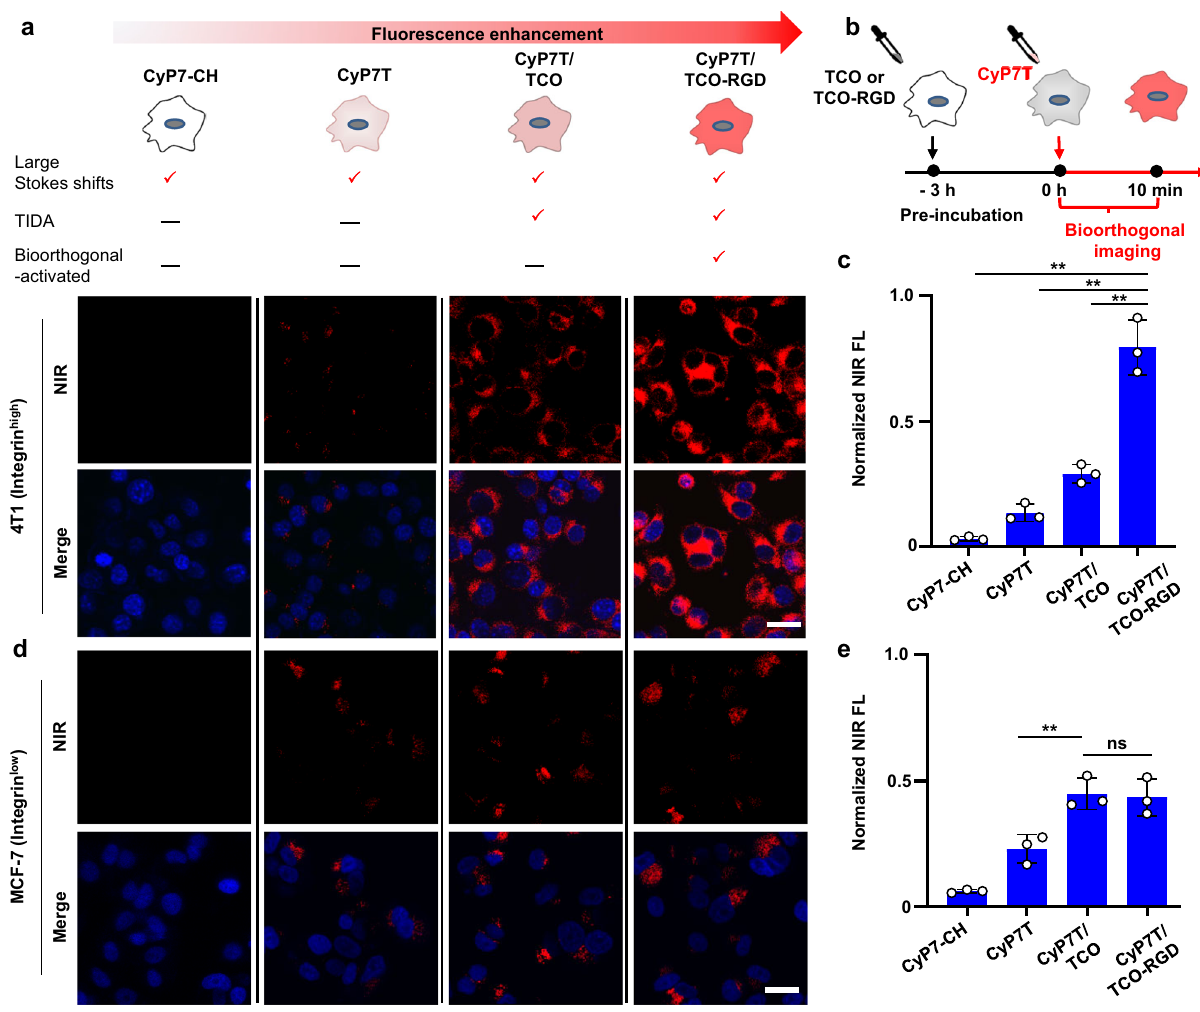
Fig. 6 Bioorthogonal-activated imaging in 4T1 cells and MCF-7 cells. a CLSM imaging of 4T1 cells (integrin α v β 3 high-expressing) incubated with CyP7T, CyP7T/TCO, and CyP7T/TCO-RGD (5 μ M) for 0.5 h. b Timeline for the addition of CyP7T and TCO/TCO-RGD. Cells were pre-incubated with 10 μ M TCO or TCO-RGD for 3 h, washed with PBS, followed by incubation with CyP7T (5 μ M) for 10 min. c Quanti fi cation of NIRF signal in a . Data are presented as mean values ± SD. A two-sided student ’ s t test was performed (CyP7T/TCO-RGD vs CyP7-CH, p = 0.0003; CyP7T/TCO-RGD vs CyP7T, p = 0.0006; CyP7T/TCO-RGD vs CyP7T/RGD, p = 0.0017). d CLSM imaging of MCF-7 cells (integrin α v β 3 low-expressing) incubated with CyP7T, CyP7T/TCO, and CyP7T/TCO-RGD (5 μ M) for 0.5 h. e Quanti fi cation of NIRF signal in d . Data are presented as mean values ± SD. A two-sided student ’ s t test was performed (CyP7T/TCO vs CyP7T, p = 0.0187; CyP7T/TCO vs CyP7T/TCO-RGD, p = 0.8359). Cells were stained with nuclear dye, DAPI (blue). All the images were acquired at 40× magni fi cation. Scale bar: 30 μ m. Error bars: standard deviation from three separate measurements. ** p < 0.01, ns not signi fi